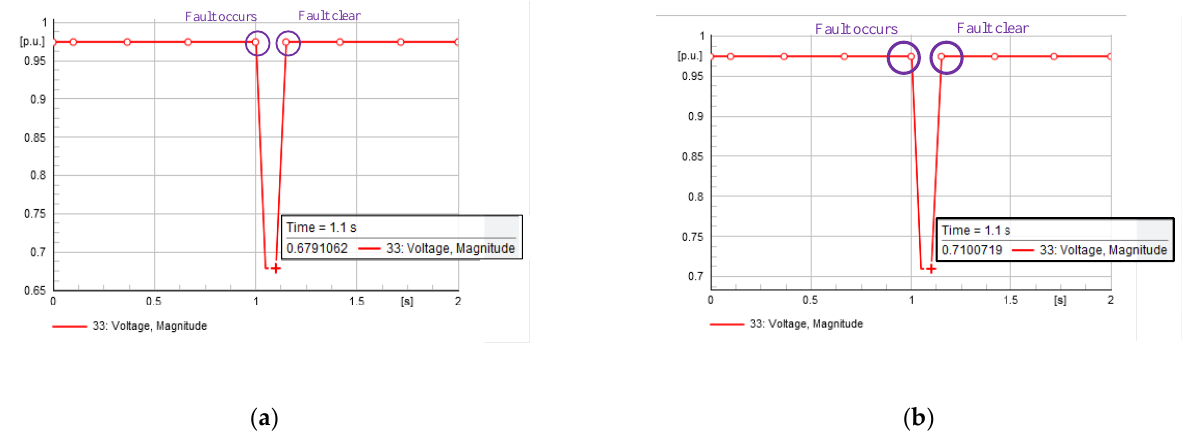
Figure 15. Fault conditions: ( a ) 417 kW capacity at bus 31 ( b ) 409 kW capacity at bus 33. Based on the results of the MOPSO algorithm, the proposed method combined with